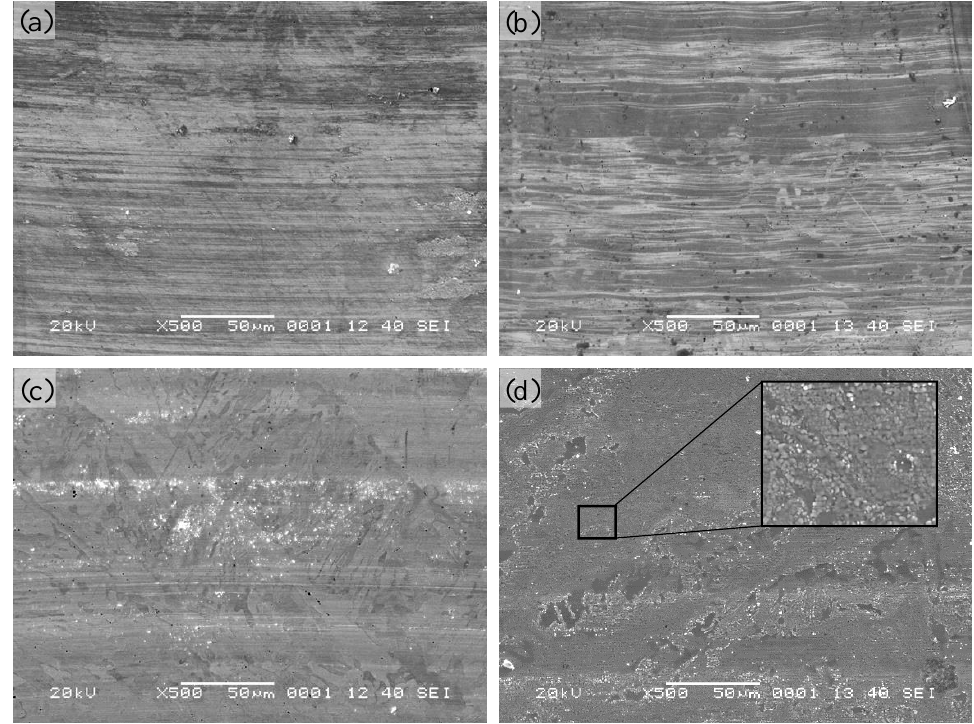
Figure 4. SEM micrographs of worn surface of pure Ni 3 Si alloy at different temperatures: ( a ) 25; ( b ) 200; ( c ) 400; ( d ) 600 °C.